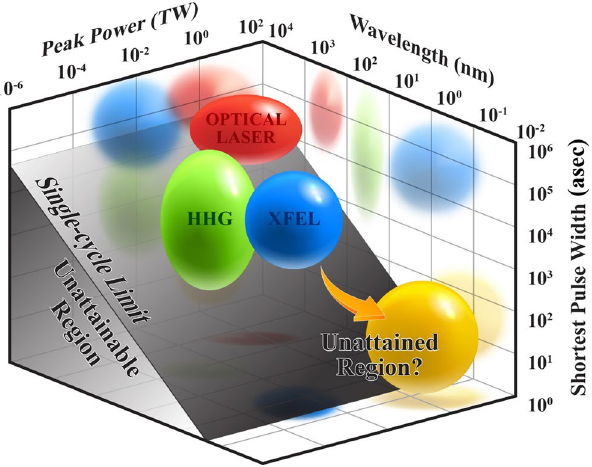
Figure 1. Current ultrafast photon sources in the view of pulse duration, wavelength and pulse power. HHG: high-order harmonic generation; XFEL: X-ray free-electron